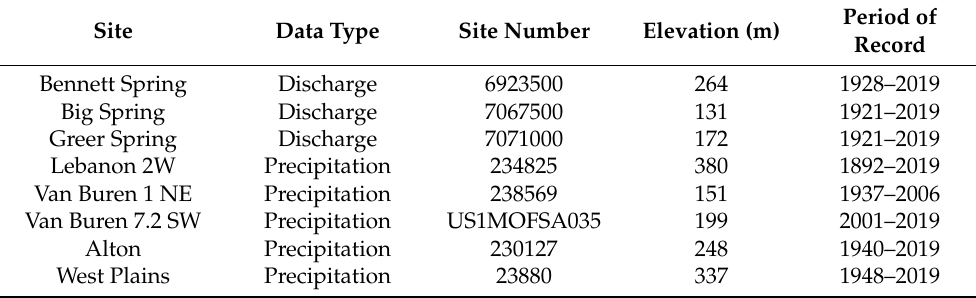
Table 1. Sources of data used in the study. Note that annual data gaps exist for all sites except Greer Spring. Elevation in m above sea level. Discharge data are taken from [44] and precipitation data from